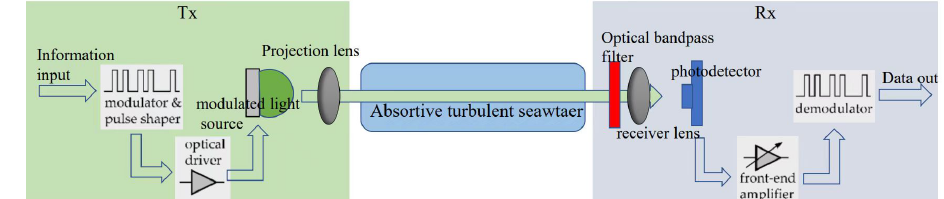
Figure 1. Schematic of underwater wireless optical communication system